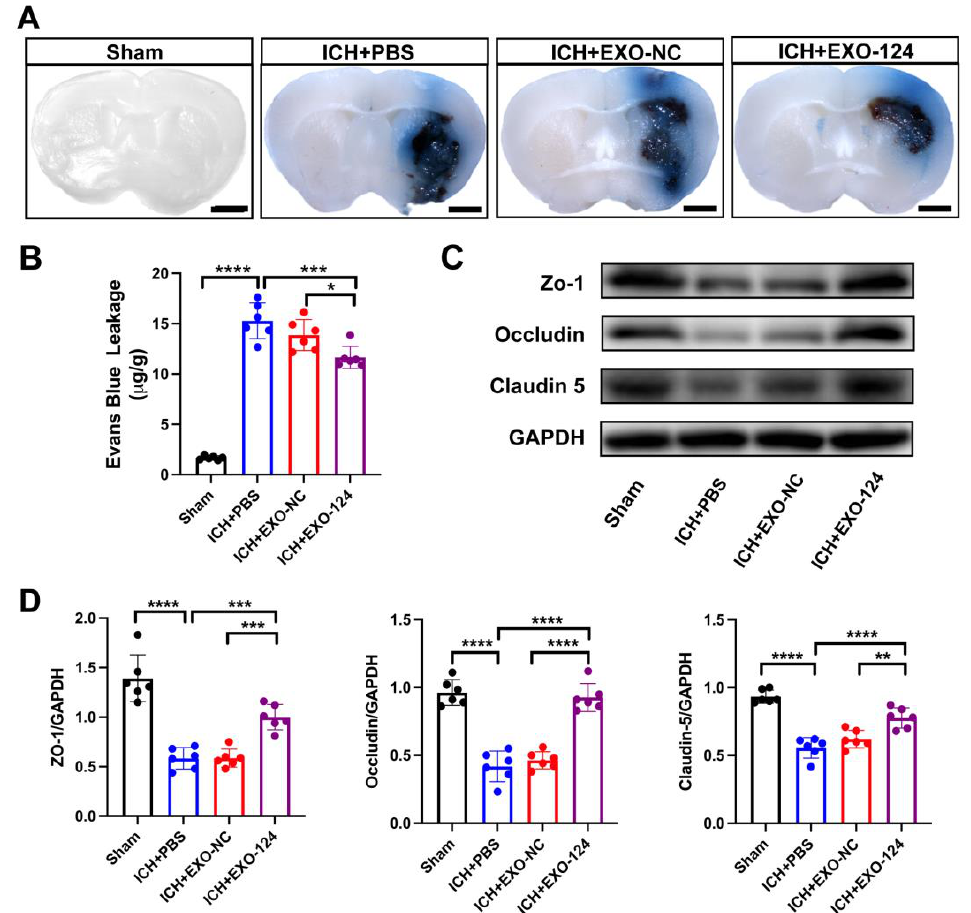
Figure 4. miRNA-124-enriched microglia-derived exosomes attenuate BBB damage. ( A , B ) Representative histological images and bar graphs showing that Evans blue dye leakage was decreased in the Exo-124 treated group compared with the PBS-treated group. Scale bar: 1 mm. n = 6/group, mean ± SD, ** p < 0.01. ( C , D ) Western blot showing that the levels of tight junction proteins, including claudin-5, occludin and ZO-1, were higher in the Exo-124-treated group. n = 6/group, mean ± SD, * p < 0.05, ** p < 0.01, *** p < 0.001, **** p < 0.0001.